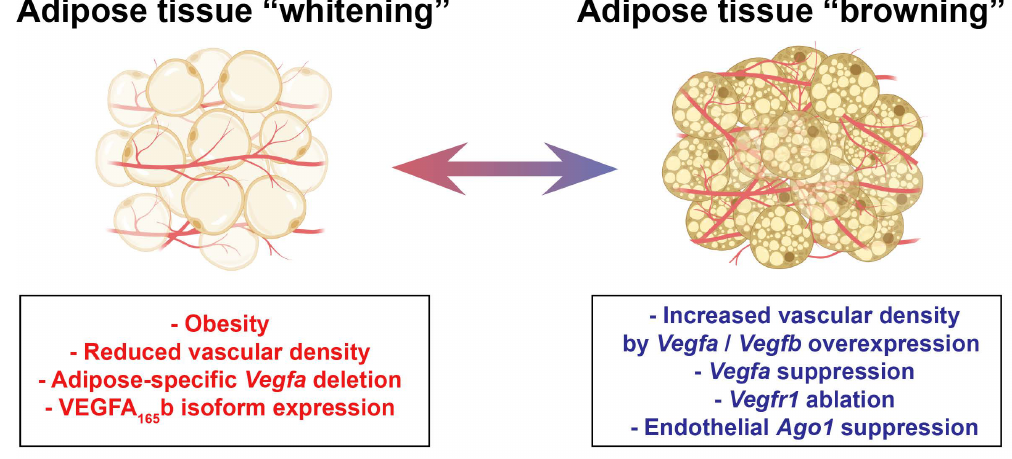
Figure 3. Endothelial regulation of adipose tissue (AT) phenotype. Factors such as diet-induced obesity [8], reduced vascular density due to a loss of Vegfa [8] or an increase in the anti-angiogenic isoform VEGFA 165 b may cause whitening of AT. On the other hand, increased vascular density due to Vegfa [74,75,83,84] or Vegfb [81] overexpression or Vegfr1 ablation [82] can induce browning of WAT in mice. Interestingly, the suppression of Vegfa expression in mice also led to a browning phenotype in WAT, suggesting that further studies are required to conclude the exact role of VEGFA in this phenomenon. Recently, endothelial protein argonaute-1 (AGO1) suppression was also shown to increase vascular density and AT browning